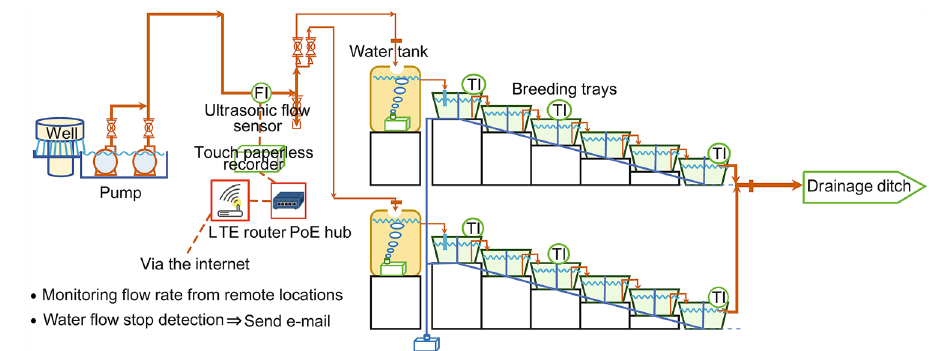
Fig. 6 Diagram of the firefly larval breeding device. LTE, long term evolution; PoE, power over Ethernet; TI, temperature indicator; FI, flow